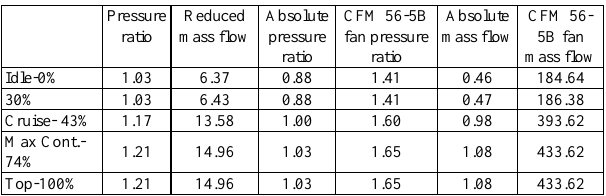
Table 10. Parameter of CFM 56-5B V = 0 Ma, H = 7000